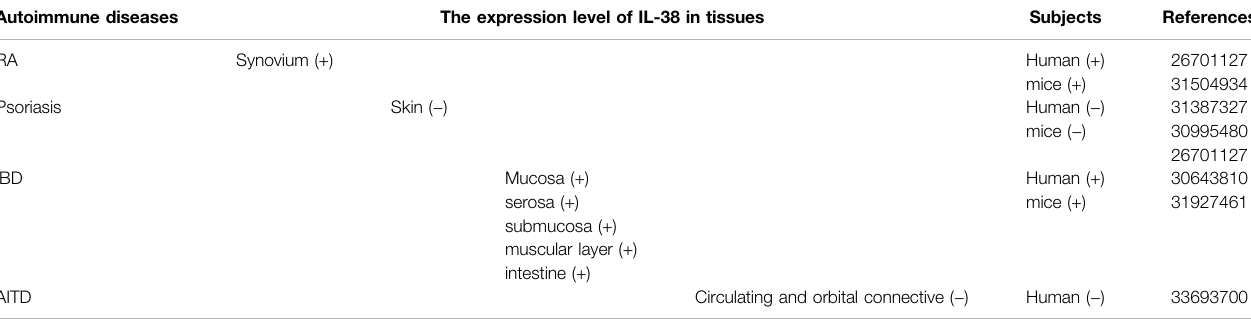
TABLE 2 | The expression level of IL-38 in tissues of autoimmune diseases. Autoimmune diseases The expression level of IL-38 in tissues Subjects